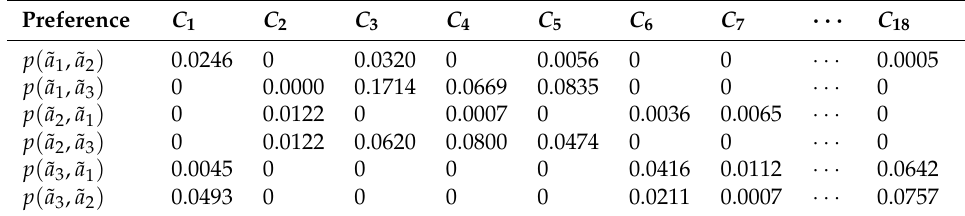
Table 8. The preference between the different venues when δ =